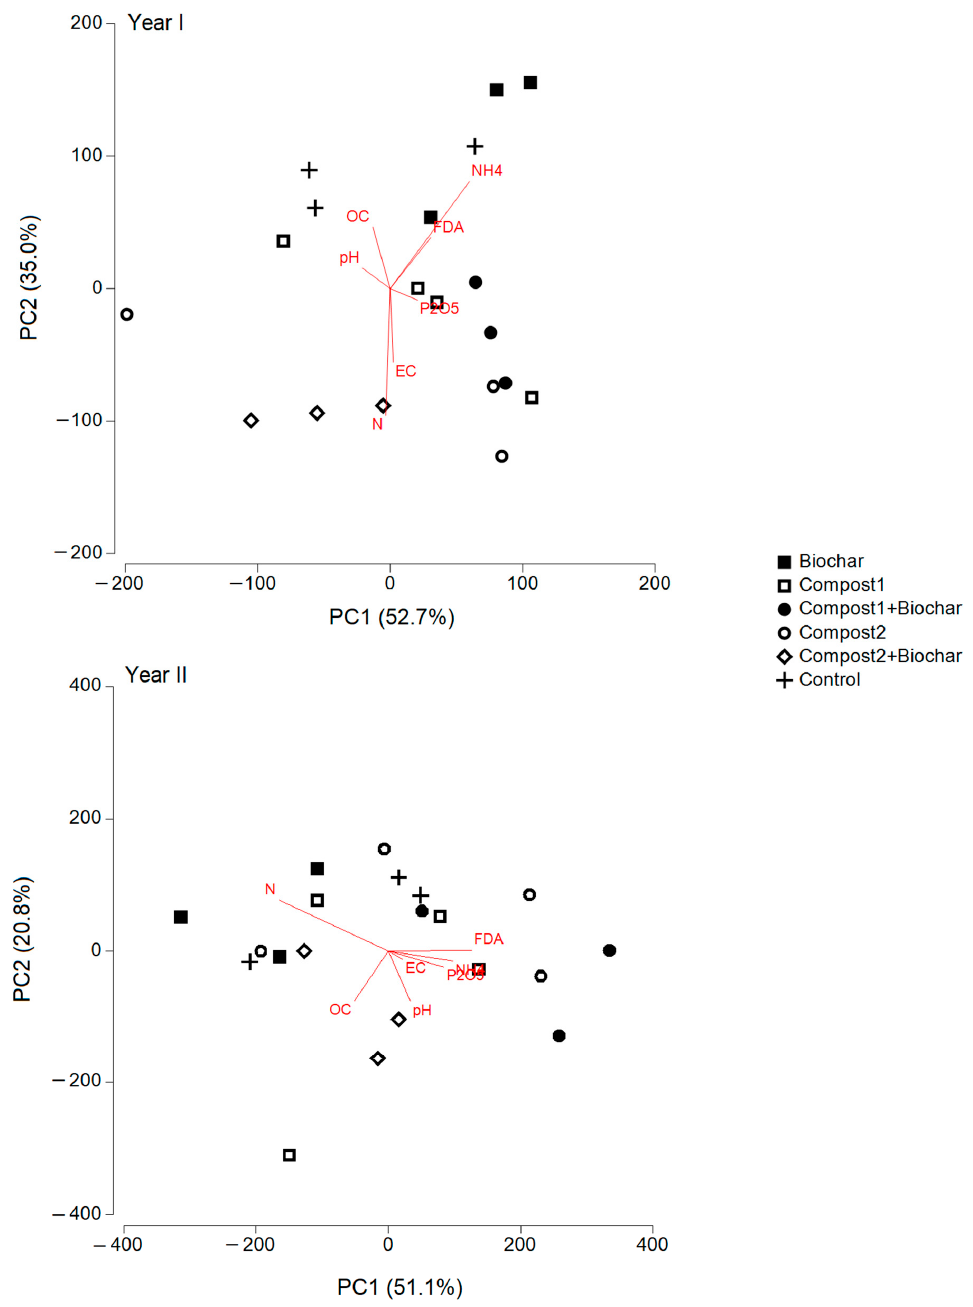
Figure 3. Principal component analysis (PCA) between biochar, compost 1, compost